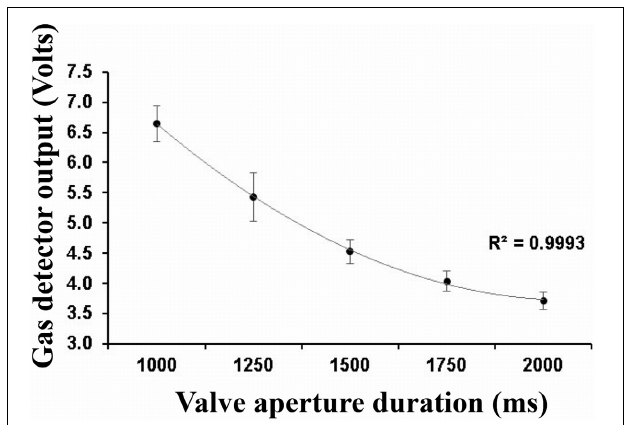
FIGURE 8 | Mean gas sensor maximum amplitude values as a function of the duration of valve aperture. Error bars indicates the 95% confidence interval. The quadratic correlation coefficient is also indicated.